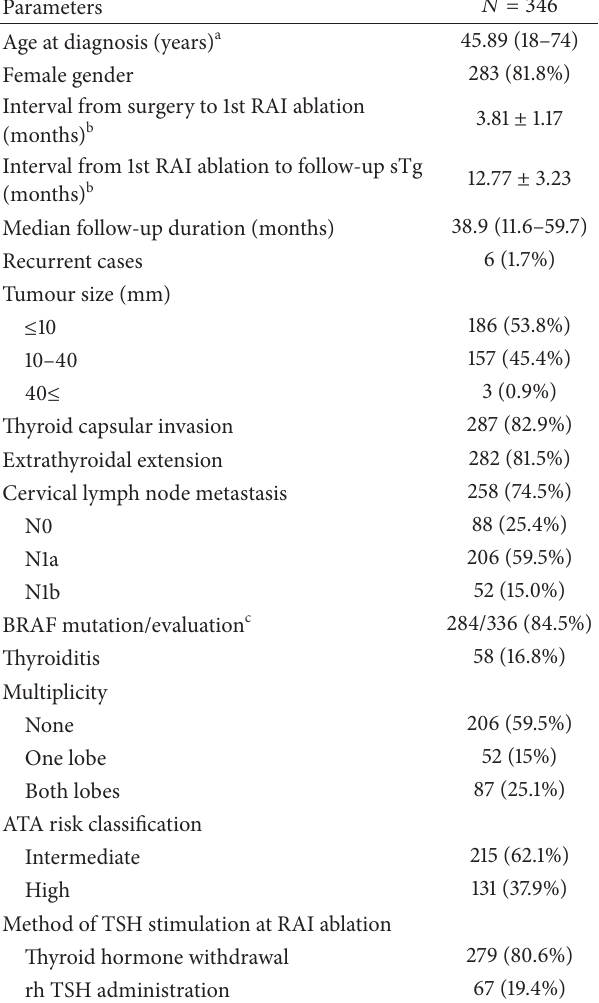
Table 1: Baseline characteristics of